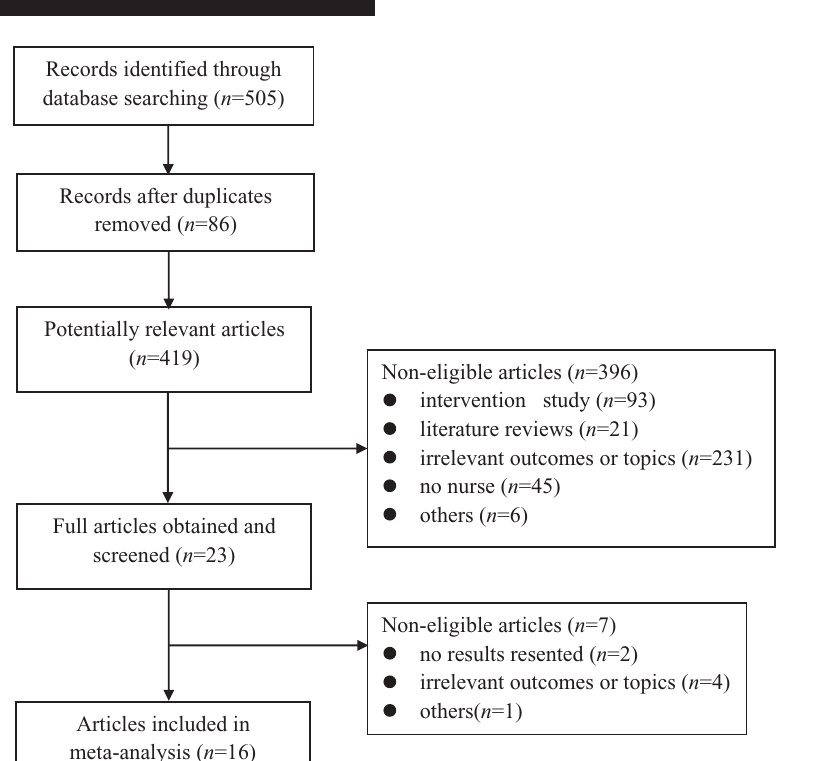
Figure 1. Screening flow